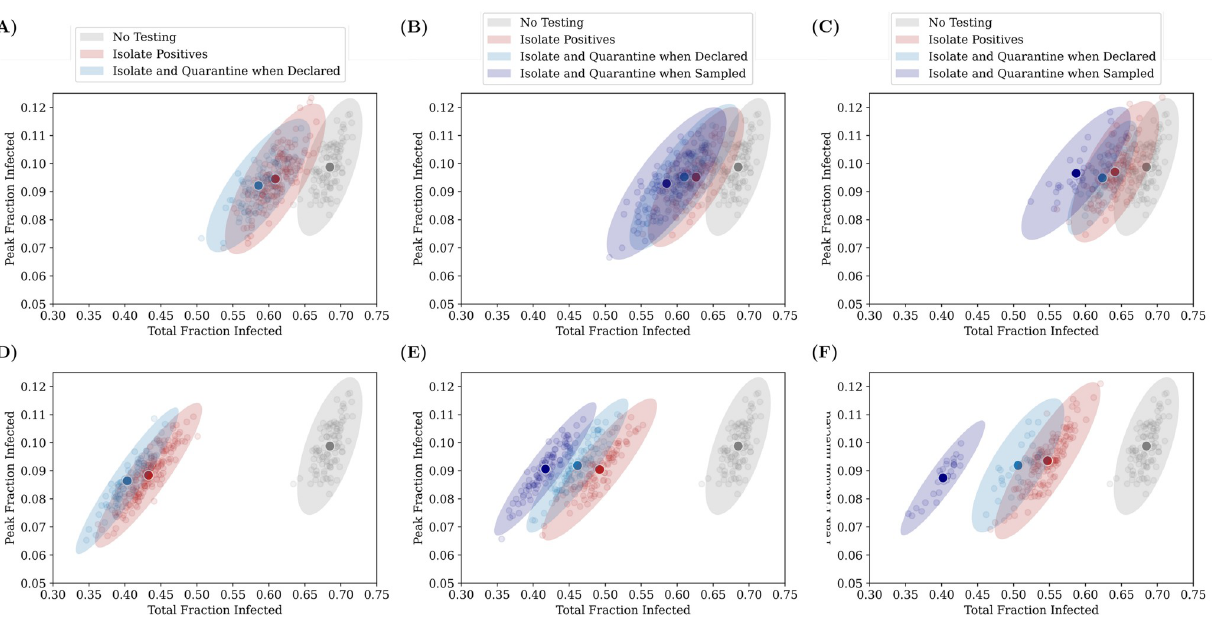
Fig 10. Relative benefits of different quarantining strategies. Each point on the graphs represents the result of a single simulation run for an RAT:PCR ratio of 80:20, and an RAT sensitivity of 75%. The darker coloured points represent the centre of mass of the points, and the ellipse radii represent three standard deviations from the mean in each direction. Ideally, we would require the peak and the total infected fraction to both be as low as possible, and therefore results closer to the bottom-left are “better” than those closer to the top-right. The top panel represents the case for a daily testing rate of 0.1%, while the bottom panel represents 0.5% testing daily. The panels on the left represent tests which have no delay (the result is declared immediately), while those in the middle and on the right represent mixtures in which PCR tests have a 2 day and 5 day delay respectively (RAT results are obtained instantaneously). The three quarantining strategies (see Methods) are compared—we find that quarantining when the test sample is taken is the most effective strategy. 100 simulation runs were conducted for each strategy, for a duration of 200 days.